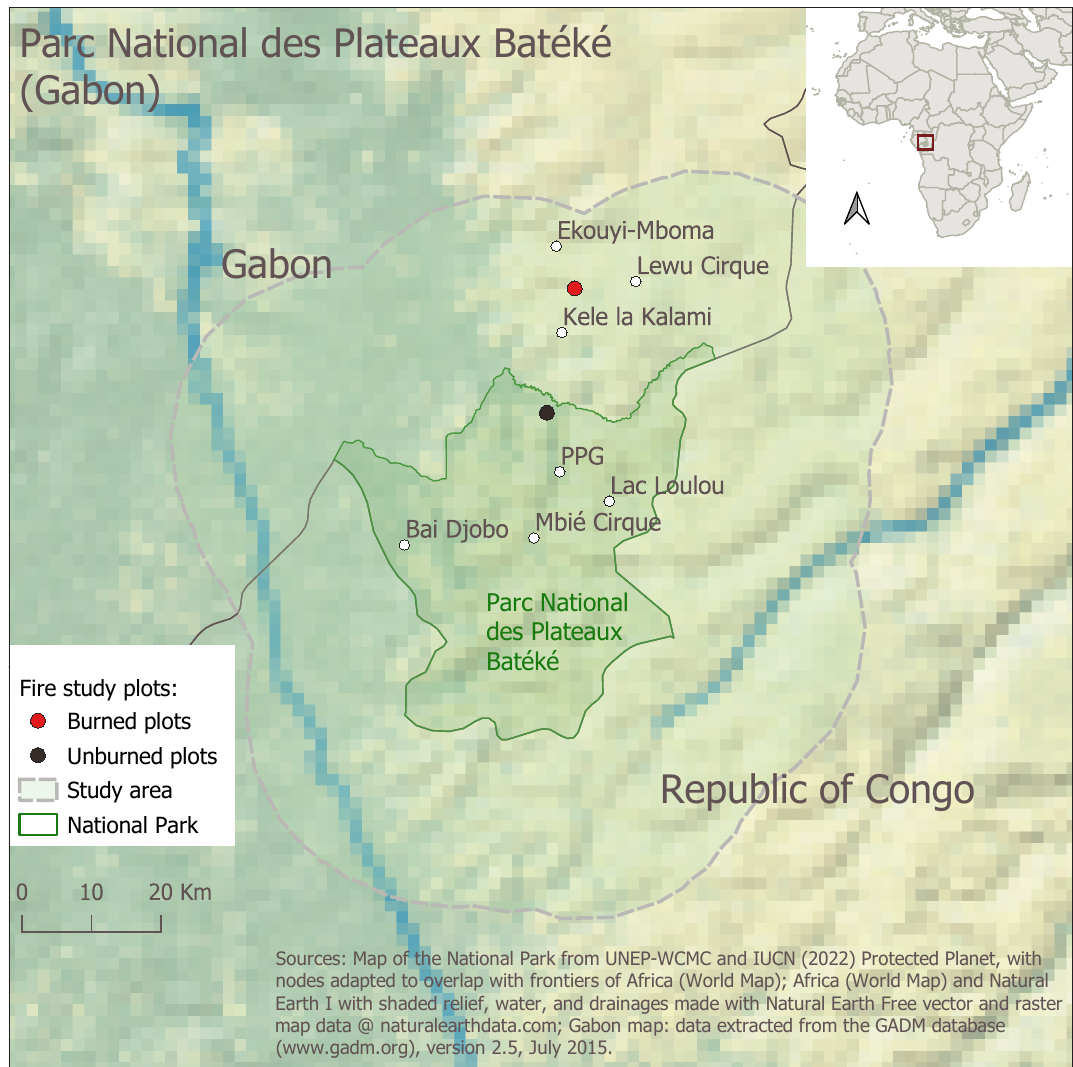
Earth I with shaded relief, water, and drainages made with Natural Earth Free vector and raster map data @ naturalearthdata.com; Gabon map: data extracted from the GADM database (www.gadm.org), version 2.5, July Figure 1. Map of the study area, including the Plateaux Batéké National Park.